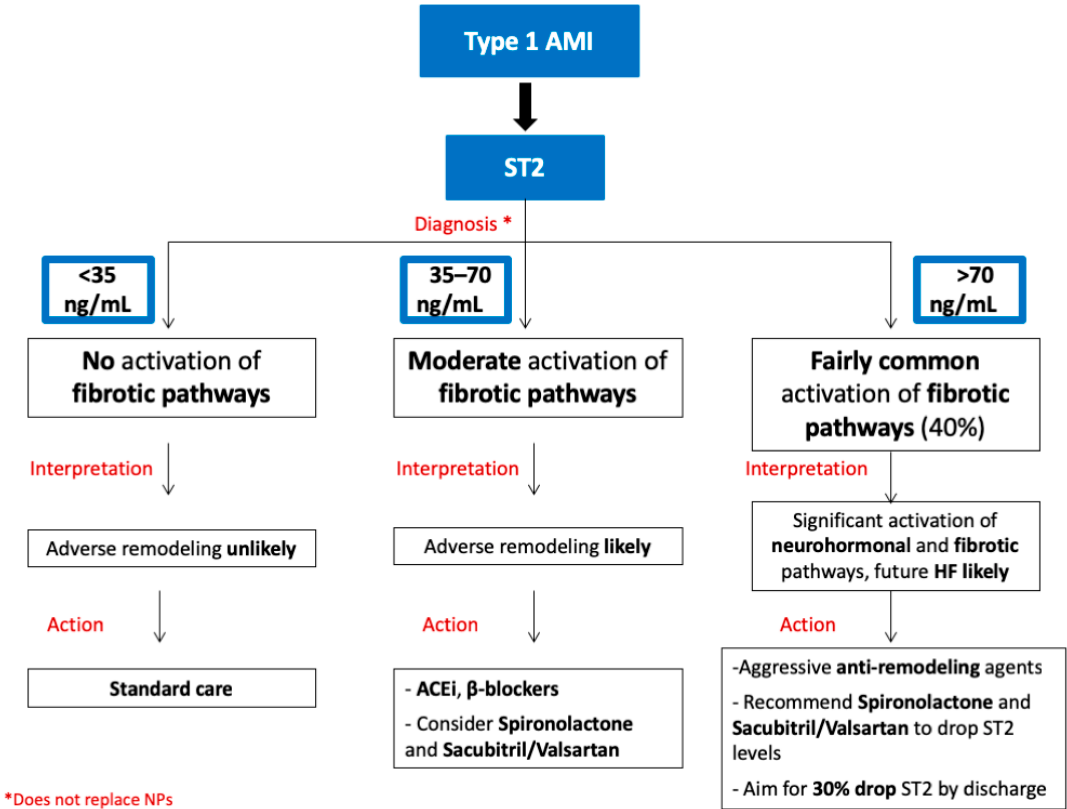
Figure 2. Flowchart summarizing soluble ST2 (sST2) aided therapeutic decision-making for patients with type 1 myocardial infarction. In patients with type 1 acute myocardial infarction (AMI), sST2 levels can help to identify 3 classes of patients. If sST2 <35 ng/mL, adverse remodeling is unlikely. In patients with 35 ≤ sST2 ≤ 70 ng/mL, adverse remodeling is more likely, and patients could benefit from antifibrotic therapies. If sST2 >70 ng/mL, adverse remodeling is fairly common, requiring aggressive anti-remodeling therapies. Suggested actions for each class of patients are shown in the panels below.